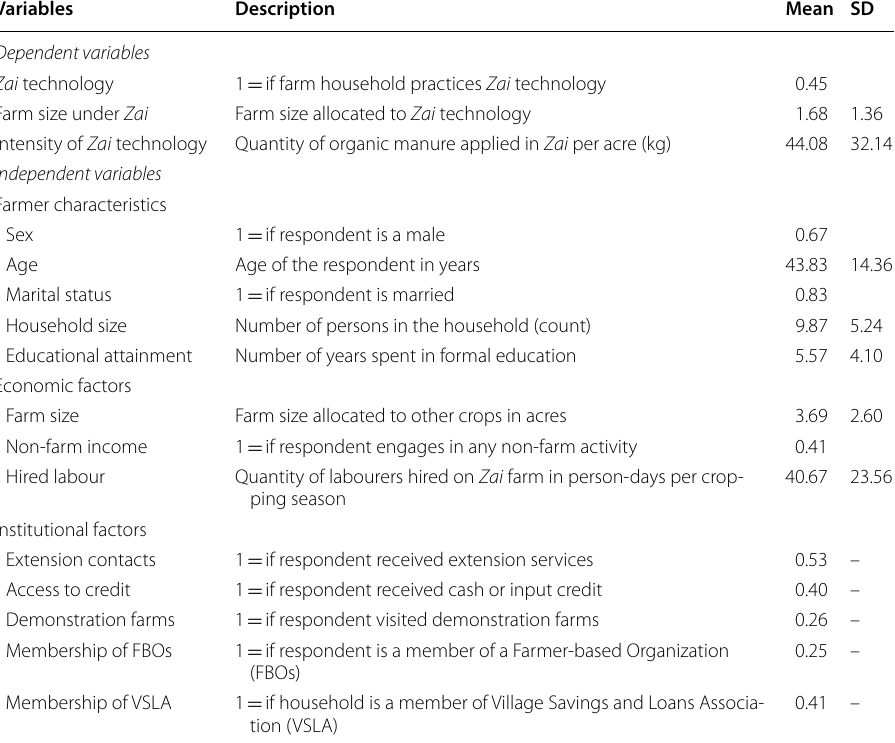
SD denotes standard deviations